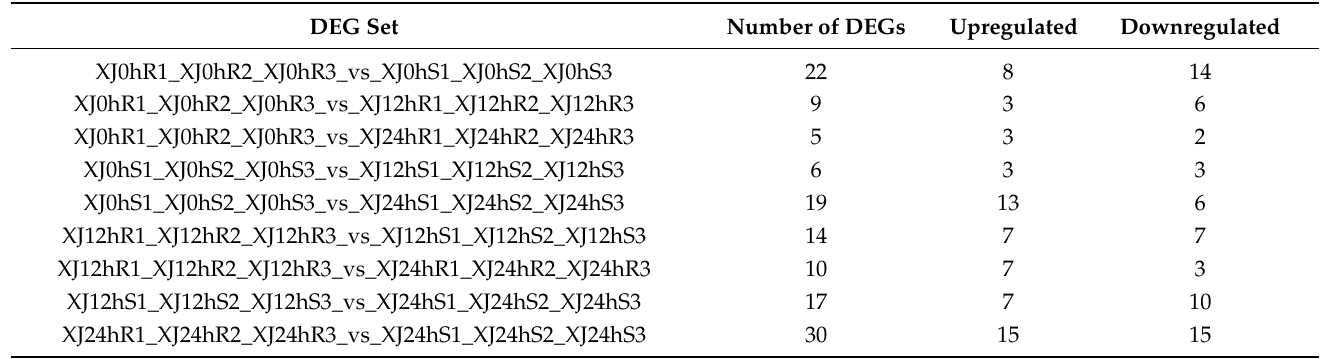
Table 5. Statistical representation of the number of differentially expressed